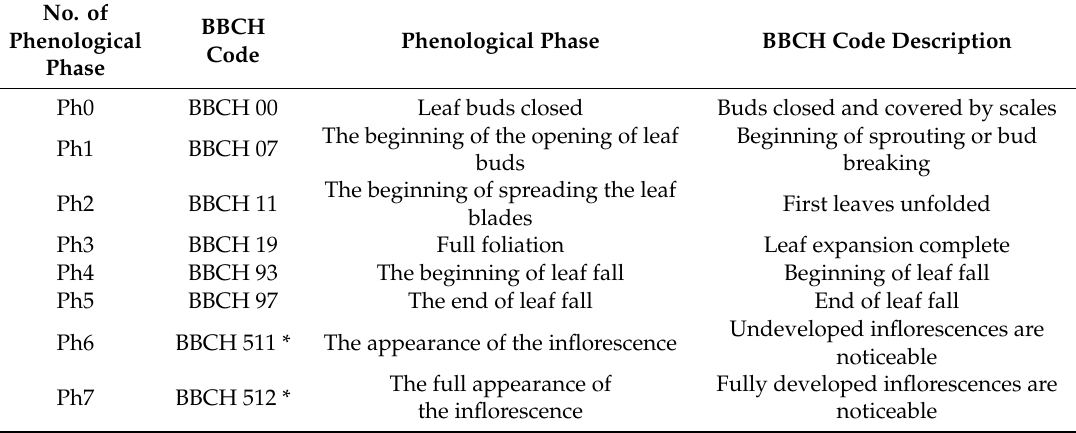
Table 2. Division and description of phenophases (based on BBCH